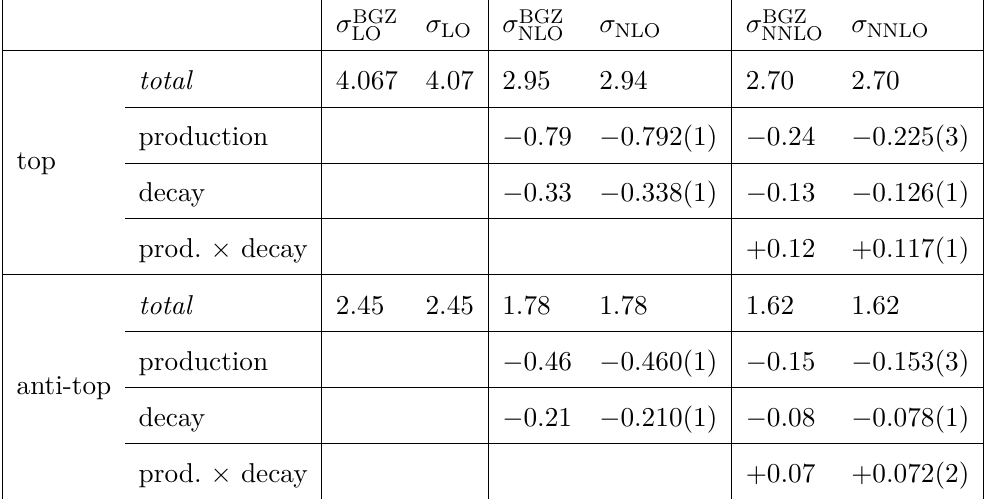
Table 6 . Comparison with fiducial results in refs. [37, 38]. Cross sections are given in